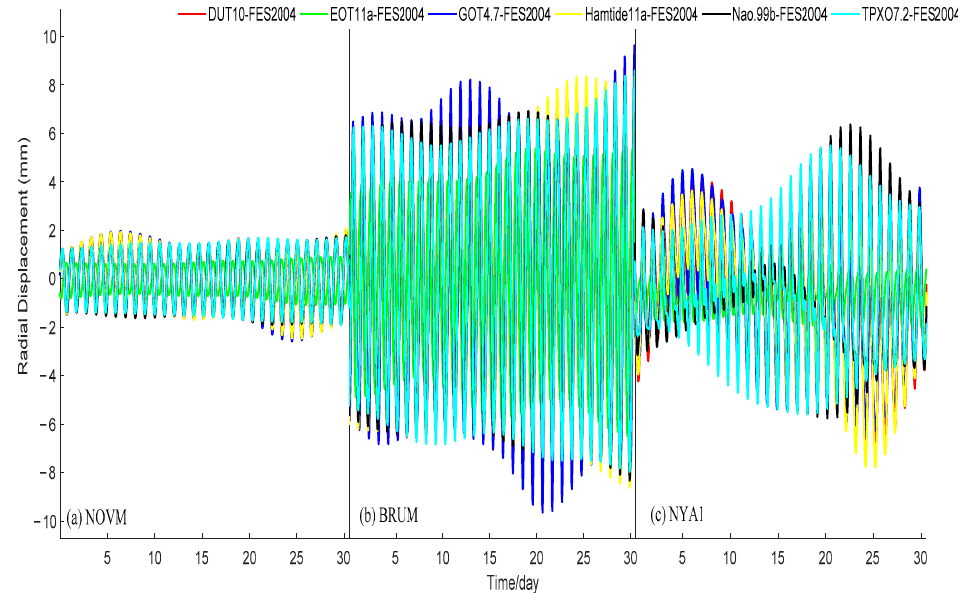
Figure 6. The difference of vertical OTL displacements between the FES2004 model (as reference) and other OTL models at the ( a ) NOVM station, ( b ) BRMU station, and ( c ) NYA1 station.